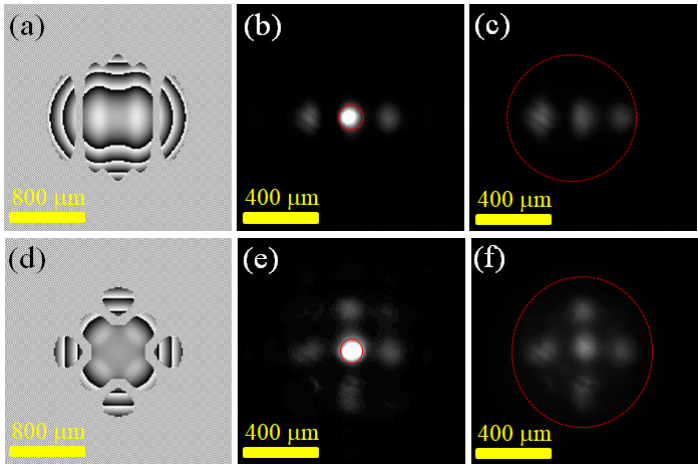
Figure 3. Experiments of generating three-point and five-point light fields with different gain regions: ( a ) SLM projected phase diagram for generating a 3-point laser; ( b ) the resulting field distributions when a small gain range is adopted; ( c ) the resulting field distributions when a large gain range is adopted; ( d ) the SLM projected phase diagram for generating a 5-point laser; ( e ) the resulting field distributions when a small gain range is adopted; ( f ) the resulting field distributions when a large gain range is adopted.